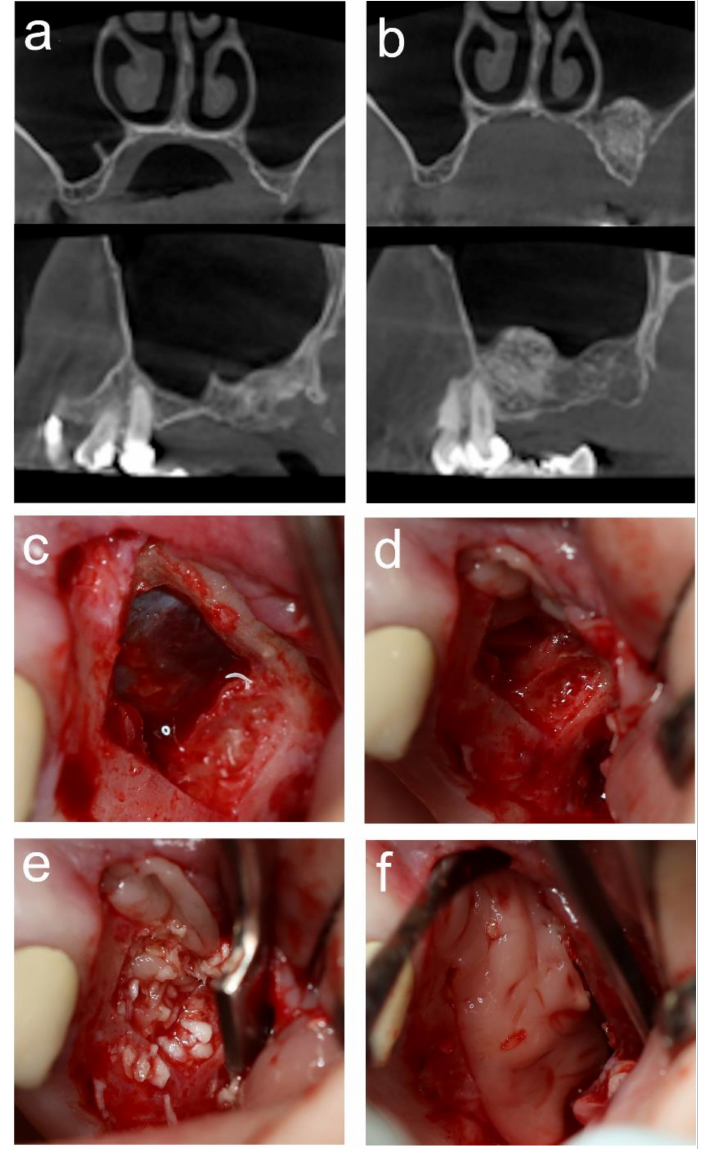
Figure 1. Representative cone-beam computed tomography (CBCT) images are shown from the test group before maxillary sinus augmentation. (MSA) ( a ) and after 3 months of healing ( b ). The main steps of MSA were as follows: piezoelectric osteotomy was carried out, and the bony window was removed to expose the Schneiderian membrane (SM) ( c ). SM was elevated and then covered with two pieces of advanced platelet-rich fibrin (A-PRF) membrane ( d ). Serum albumin-coated bone allograft particles were mixed with A-PRF and gently packed into the created space ( e ). The lateral window was covered with the previously removed bony wall and an A-PRF membrane ( f